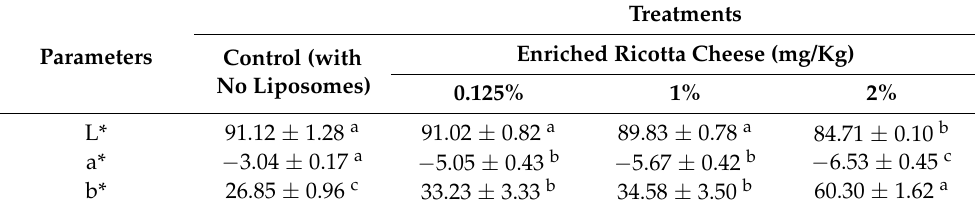
Table 4. Color parameters of ricotta cheese enriched with various concentrations of liposomal saffron